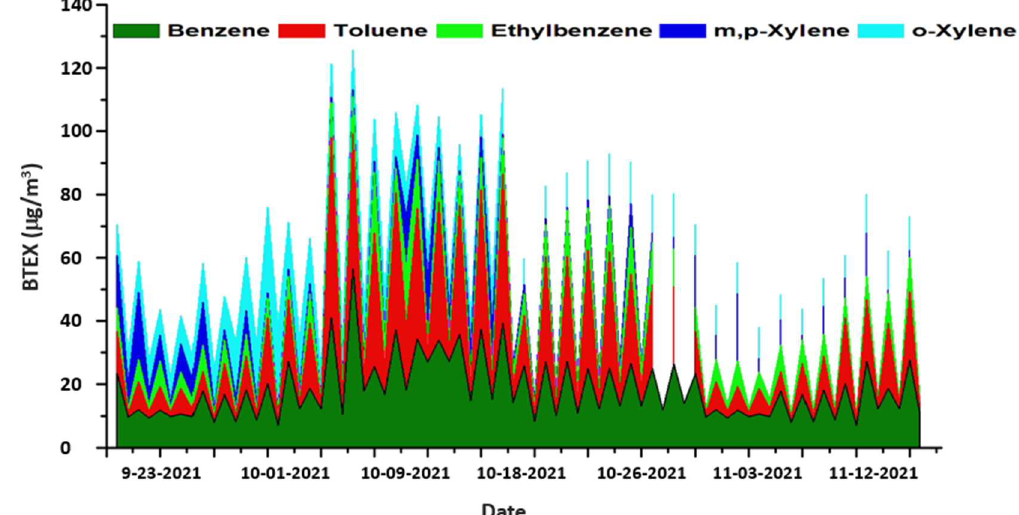
Figure 4. BTEX concentrations during the pre-harvest and post-harvest period.